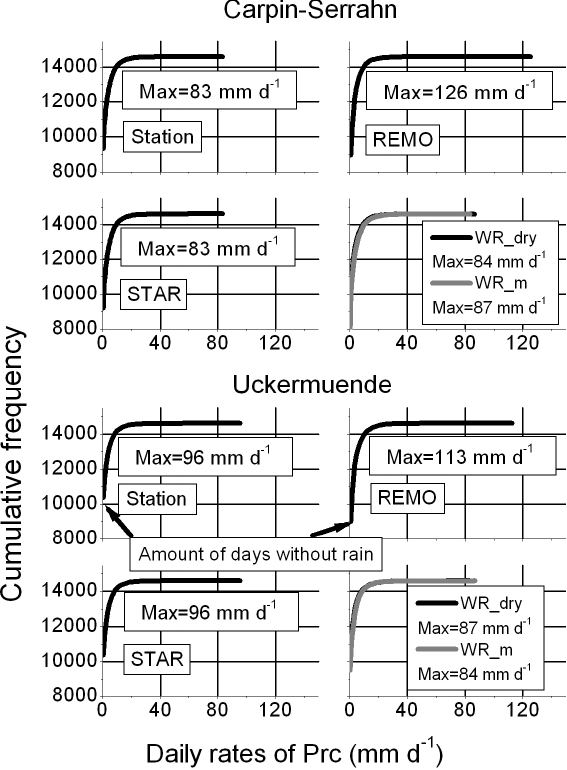
Fig. 4. Cumulative frequency curve and maximum (=Max) of daily precipitation rates (=Prc) of the control period 1961–2000 mea- sured at the weather stations Ueckerm¨unde and Carpin-Serrahn in comprison with corresponding curves obtained from the climate change scenarios REMO, STAR, Wettreg dry (=Wr dry) and Wet- tReg middle (=WR